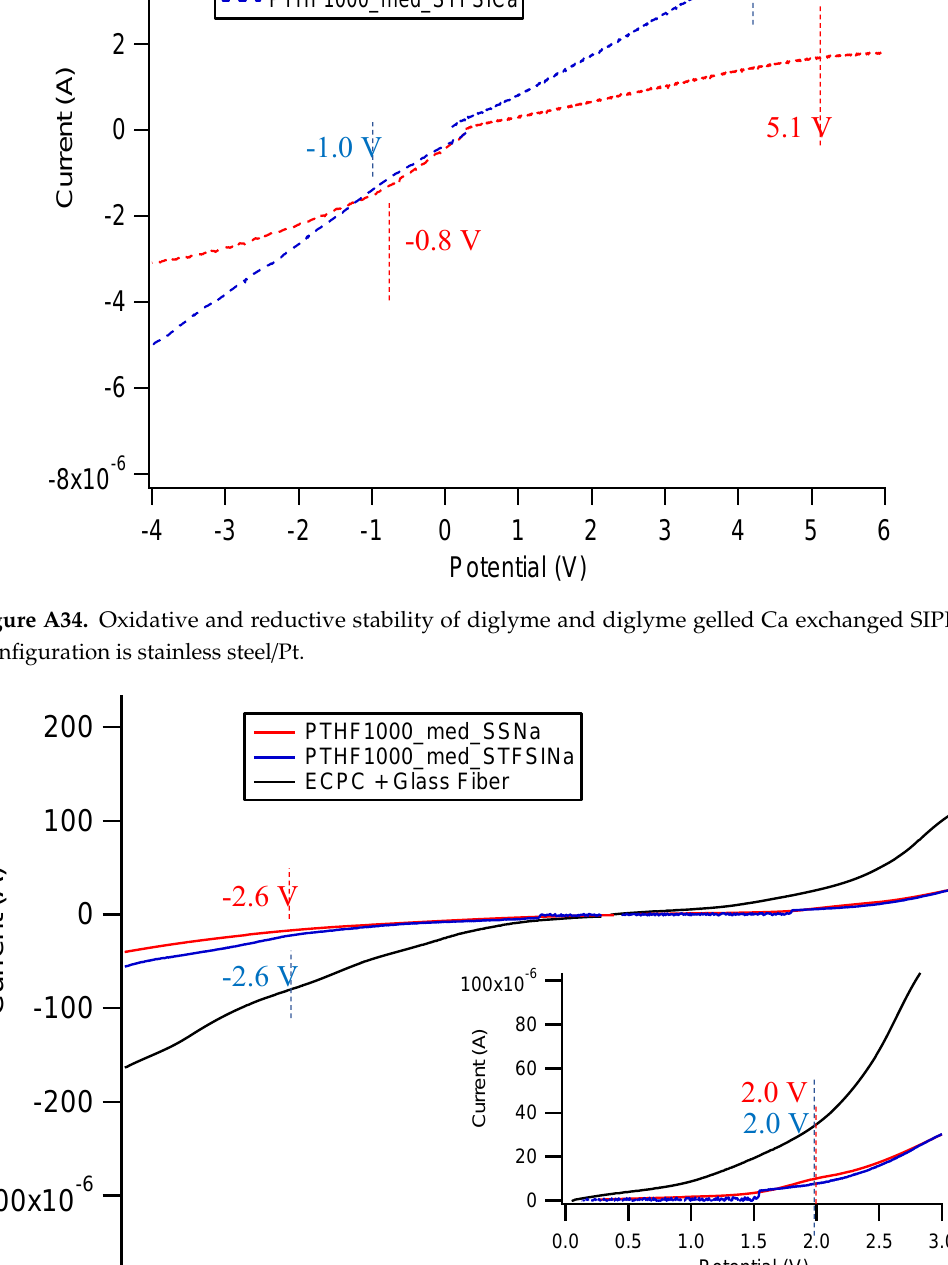
Figure A33. Oxidative and reductive stability of diglyme and diglyme gelled Na exchanged SIPEs. Configuration is stainless steel/Pt.